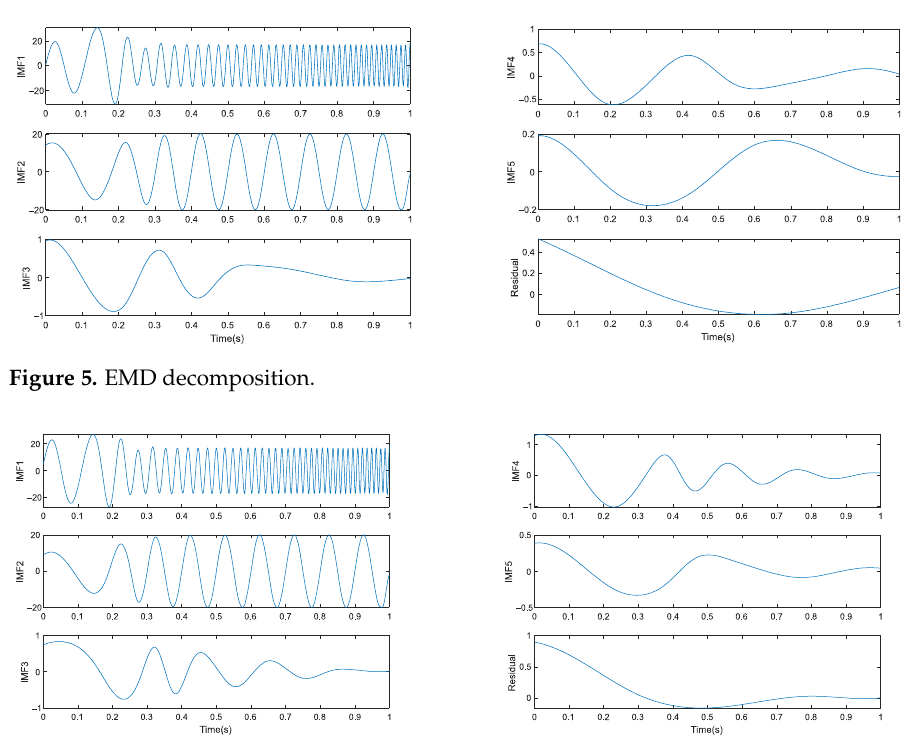
Figure 4. The signal without noise.